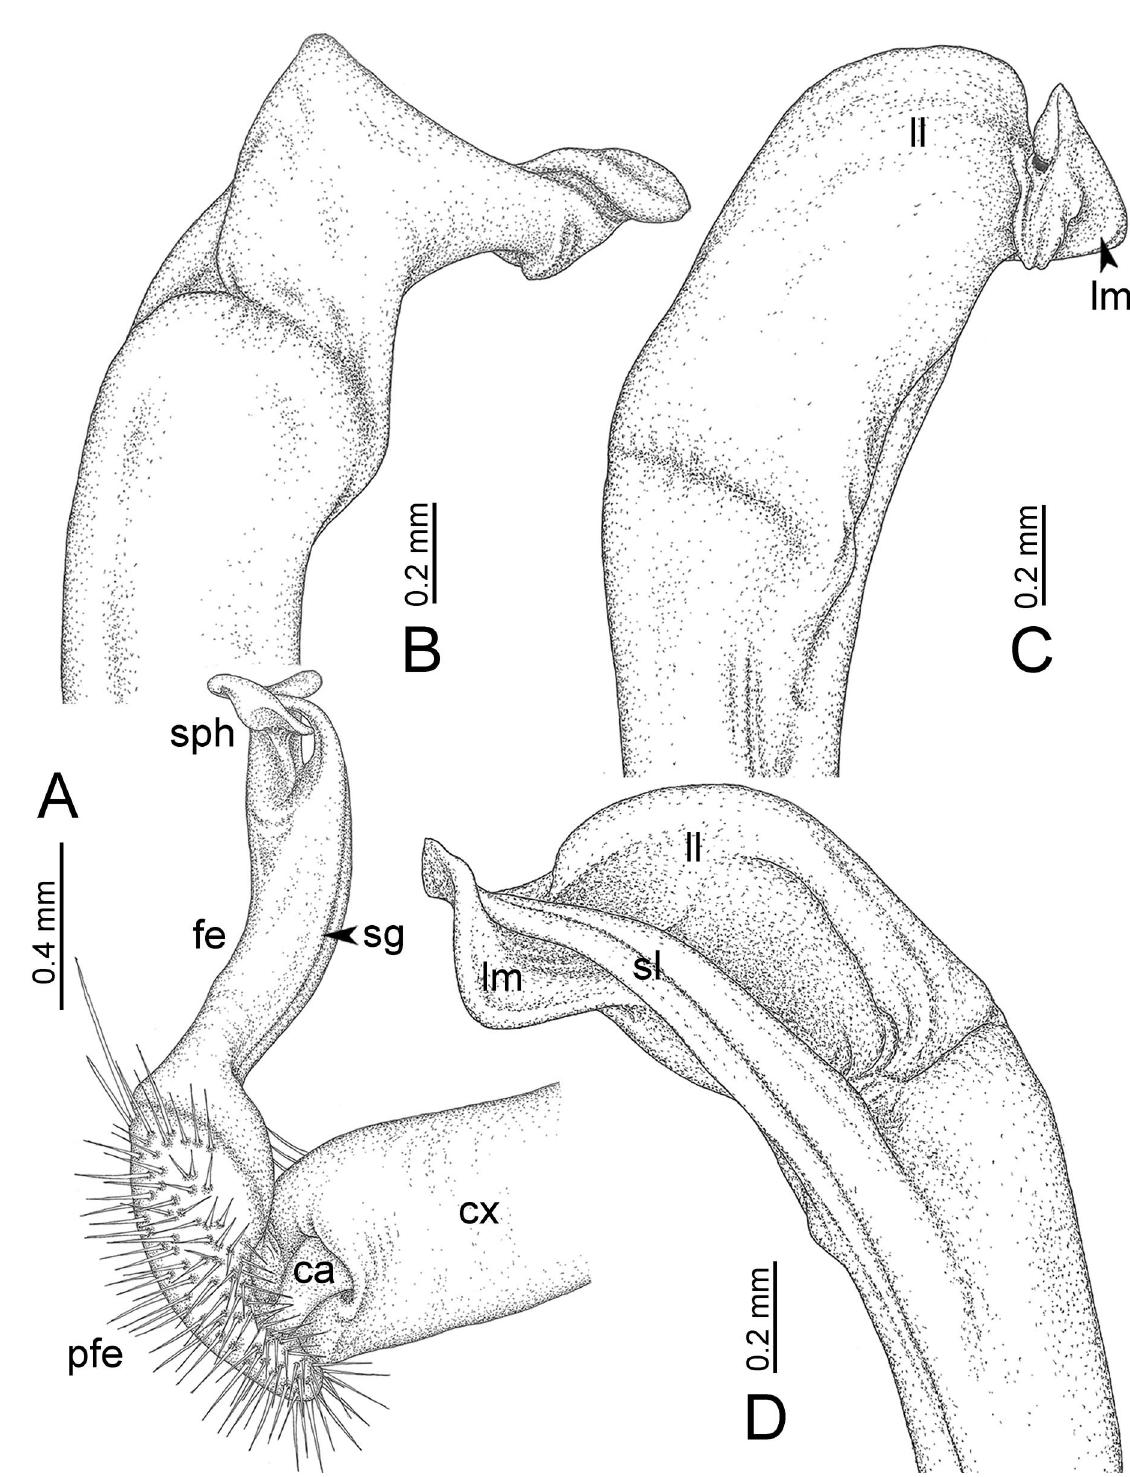
Fig. 12. Gigaxytes gigas (Golovatch & Enghoff, 1994) gen. et comb. nov., ♂, specimen from Wat Tham Sue (Tiger Cave) – right gonopod. A . Mesal view. B . Lateral view. C . Ventral view. D . Dorsal